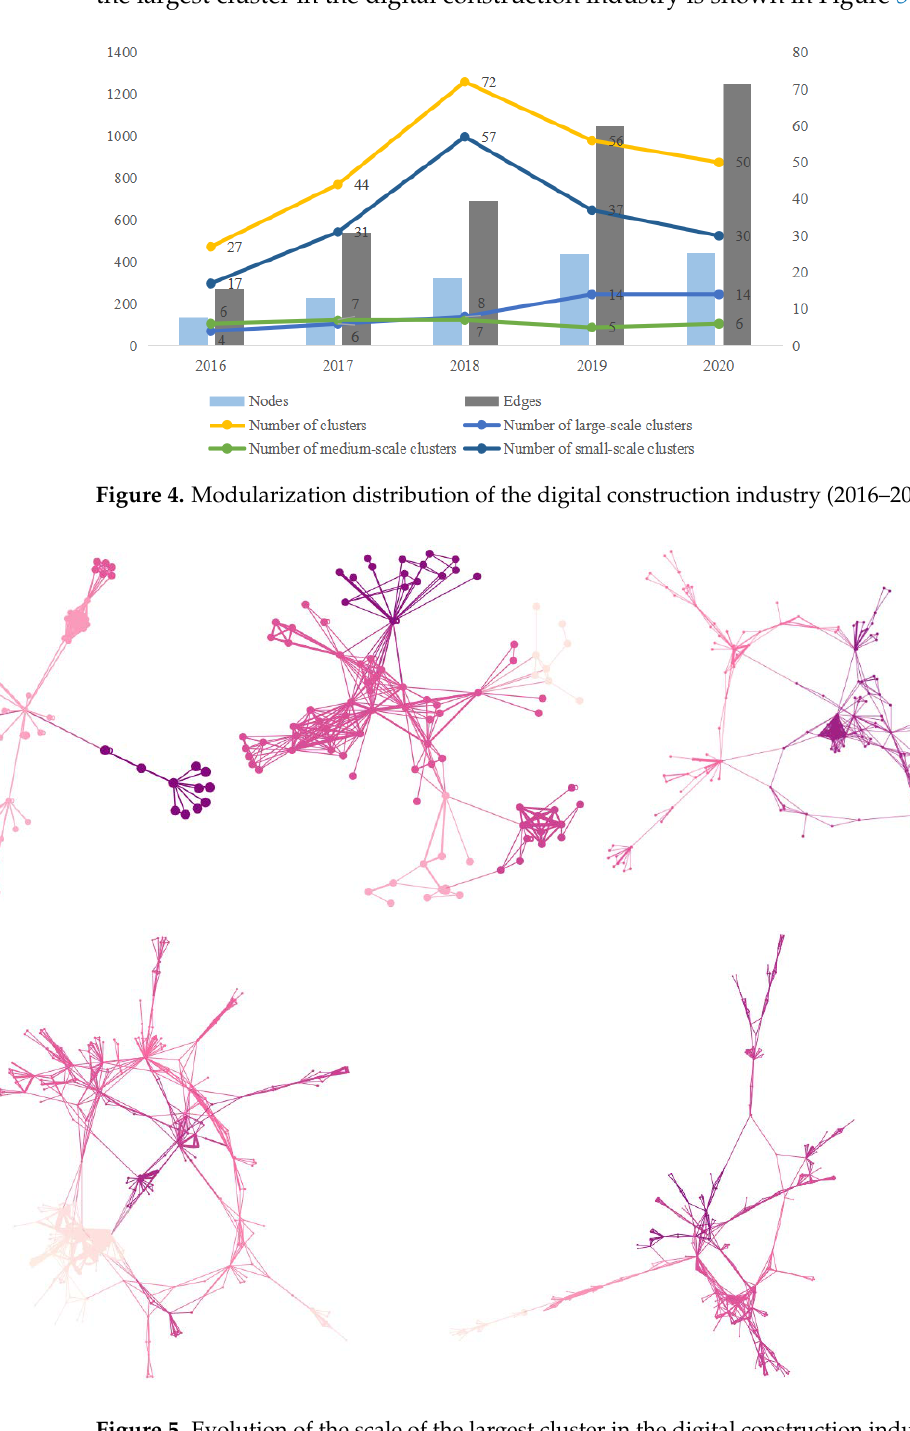
Figure 5. Evolution of the scale of the largest cluster in the digital construction industry (2016–